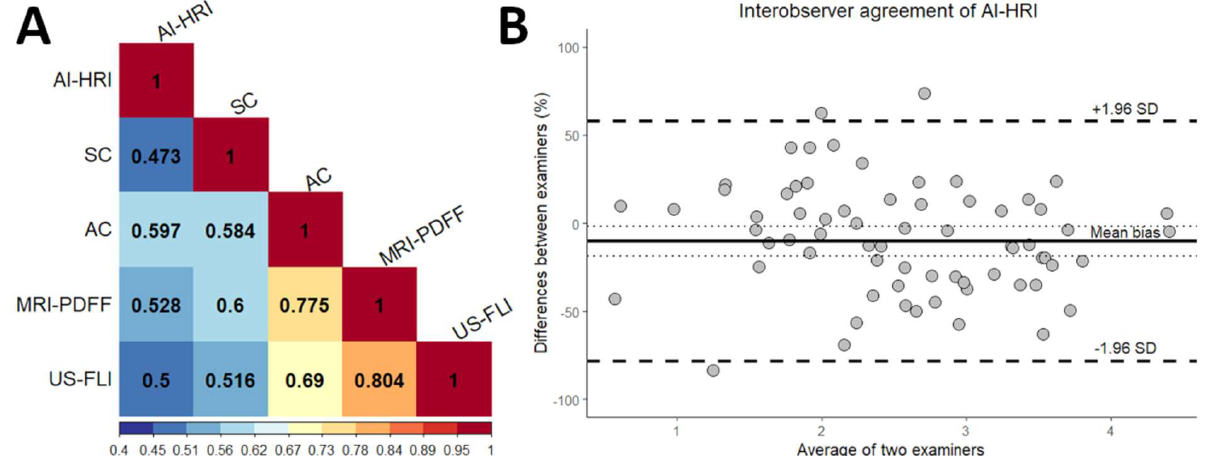
Figure 5. ( A ) The correlation matrix between imaging methods is displayed on a colored heat map. The amount of steatosis was determined with quantitative ultrasound (QUS) metrics, including artificial intelligence-calculated hepatorenal index (AI-HRI) and ultrasound attenuation coefficient (AC), ultrasound backscatter-distribution coefficient (SC), and semi-quantitative ultrasonographic